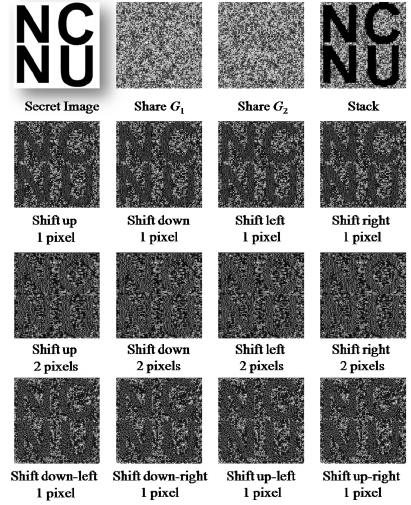
Figure 6. The experimental results for n = 5.